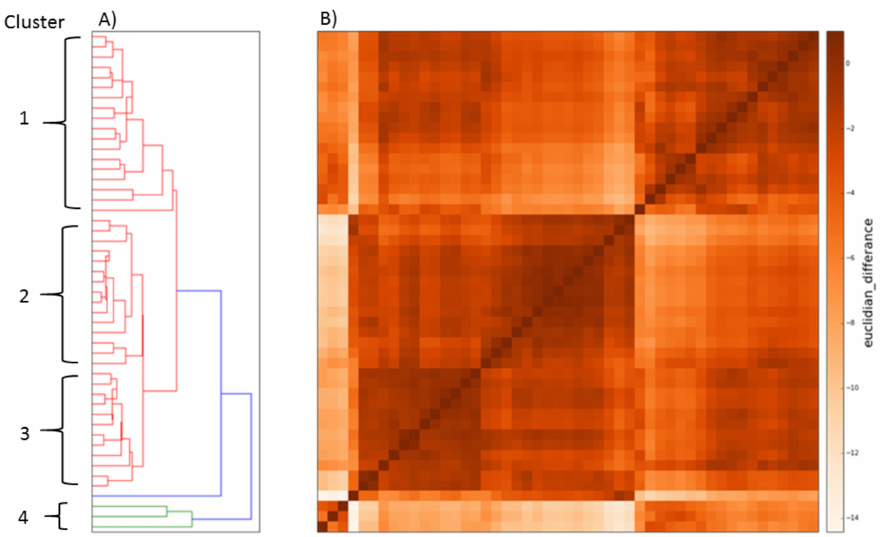
Figure 3. Clusters defined from ( A ) dendrogram and ( B ) heat map following cluster analysis. The single trace was excluded from the numerical analysis due to missing